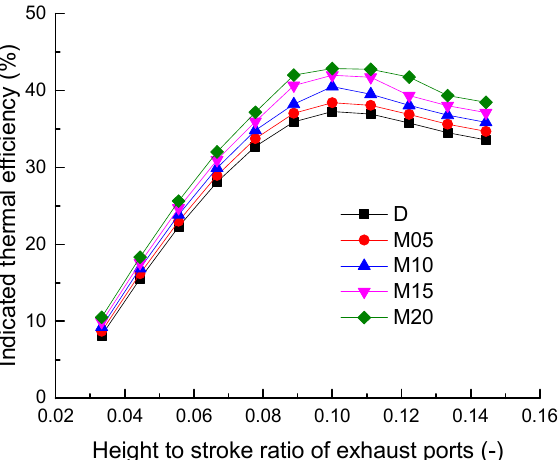
Figure 8. Indicated thermal efficiency under different HSRs of exhaust ports.